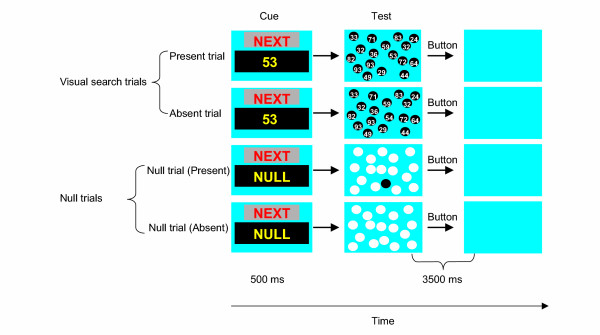
Time course of the stimulus display sequence of the task trials. For present and absent trials, a randomly selected digit from 20 to 99 was presented on the centre of the viewing screen for 500 ms, followed by a test sequence of digits (targets) presented for 3,500 ms. In a given trial, subjects judged whether the digit first presented was among the targets. If they believed the presented target digit matched the first digit, subjects pressed the left button (present trial); if not, they pressed the right button (absent trial). There was no time interval between trials. For the null trial, the word "NULL" was presented on the centre of the viewing screen for 500 ms, followed by a test sequence presented for 3,500 ms. Subjects judged whether there was a black circle among the white circles. When a black circle was present among the white ones, subjects pressed the left button; and when all of the circles were white, they pressed the right button. There was no time interval between the trials.